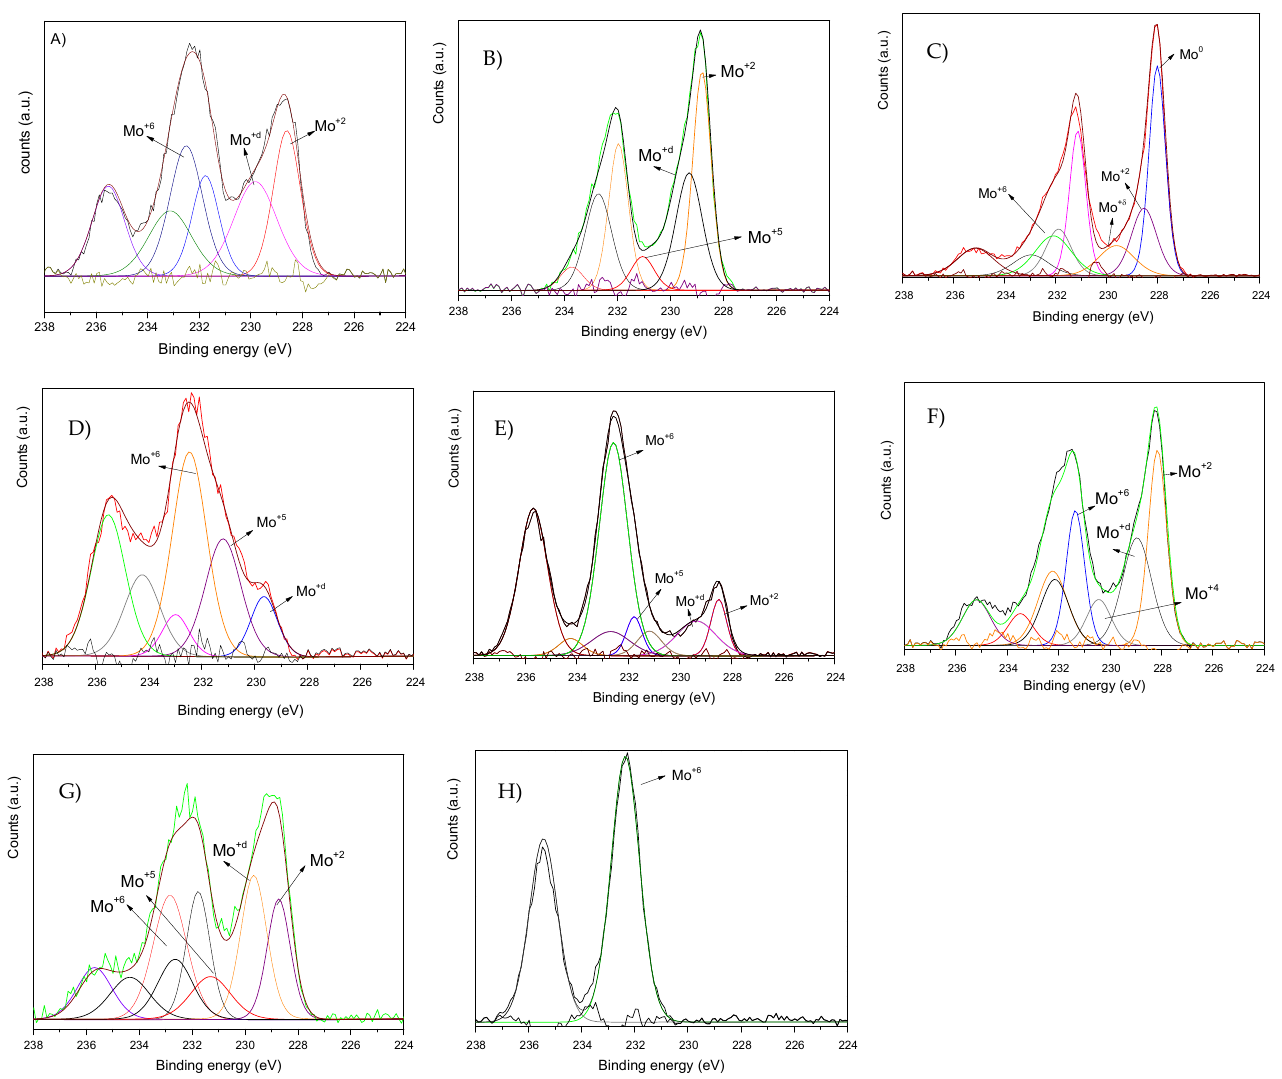
Figure 2. XPS Mo 3d Region of ( A ) CuMo x C/H550; ( B ) CuMo x C/H; ( C ) CuMo x C/H at 700 °C under H 2 ; ( D ) CuMo x C/rGO; ( E ) CuMo x C/CNT; ( F ) CuMo x C/H under He at 600 °C; ( G ) CuMo x C/H under He at 700 °C; ( H ) Spent CuMo x C/H.